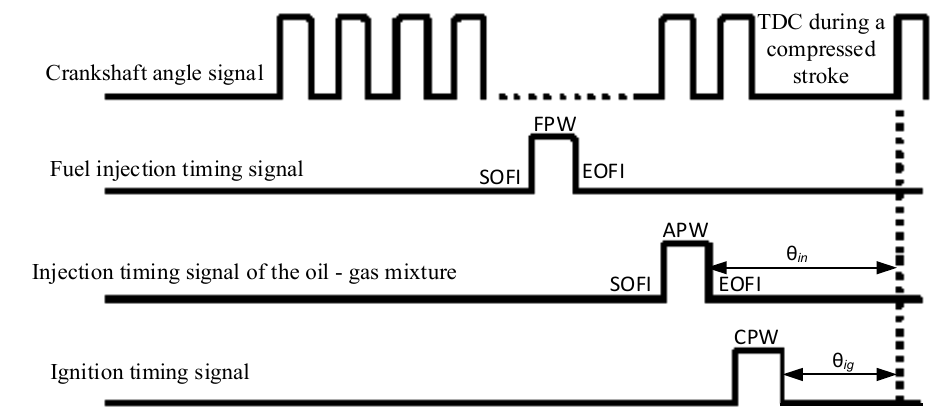
Figure 2. Timing diagram for the fuel injection and ignition parameters. The abbreviations in Figure 2 correspond to the following parameters: fuel pulse width, FPW; start of fuel injection, SOFI; end of fuel injection, EOFI; air pulse width, APW; start of air injection, SOAI; end of air injection, EOAI; charge pulse width, CPW.